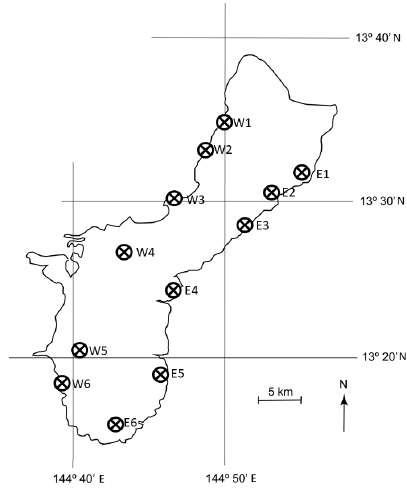
Figure 1. Location of 12 permanent localities on Guam in which the. Cycas micronesica population was observed from 2005–2020. Stem counts were conducted when each plot was established, and the data were recorded in three size categories. All plants with stems less than 10 cm in height were counted as seedlings. All plants with stems between 10 and 100 cm in height were counted as juveniles. Our formal cycad research on Guam began in 1997, and throughout 23 years of observations we have not seen any strobili on in situ C. micronesica plants less than 100 cm in height. All stems greater than 100 cm in height were counted as adults. We visited each of the 120 plots one time within each calendar year